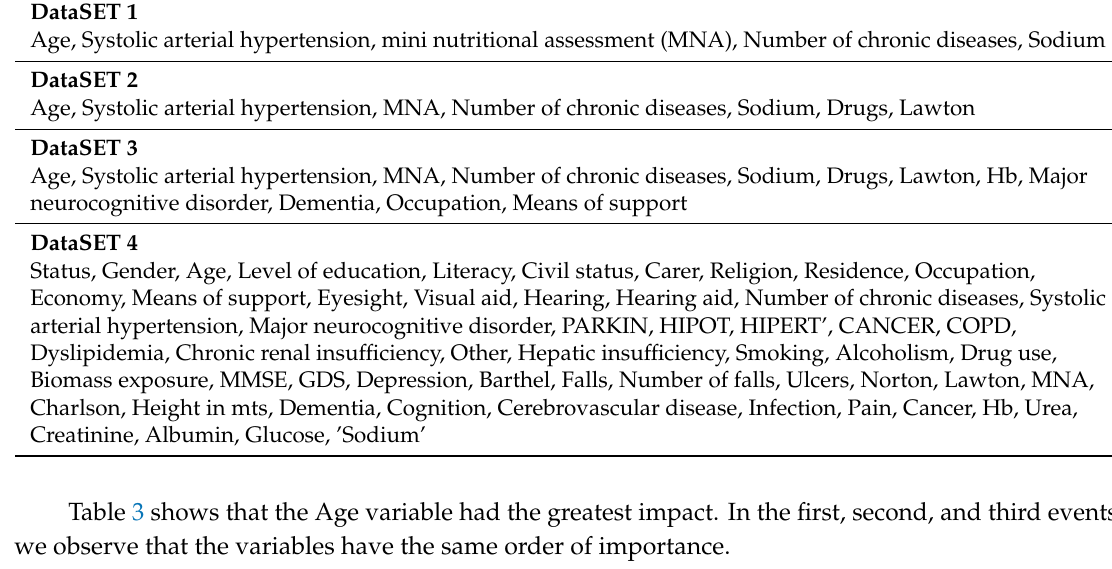
Table 3. DataSET group.